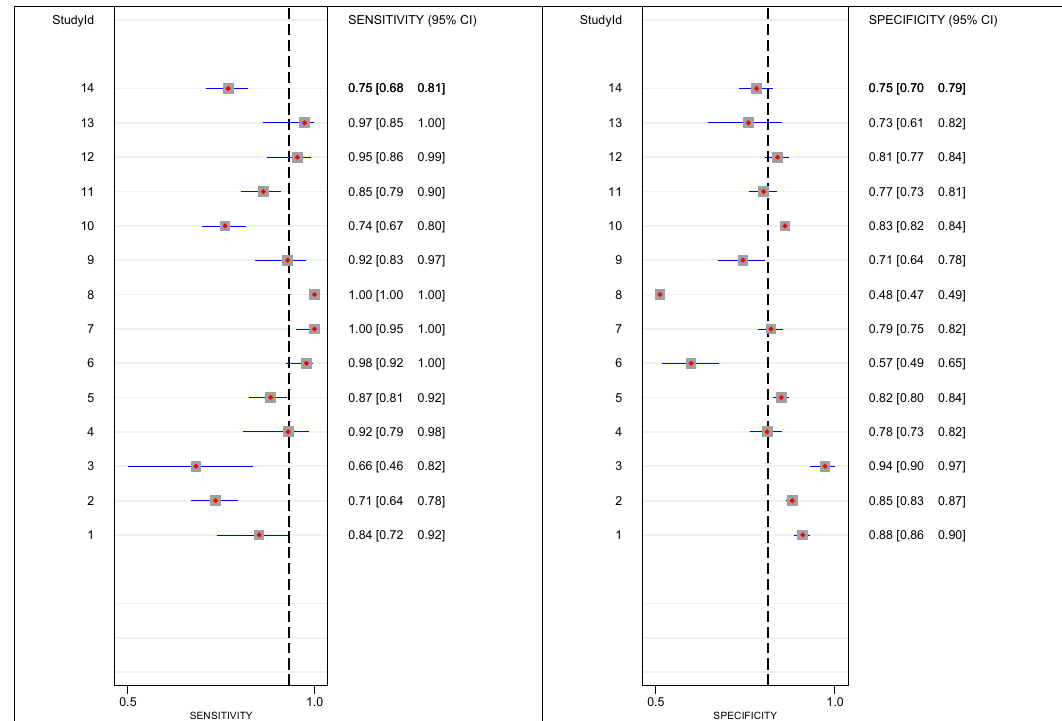
Figure 1. Graphical depiction of residual-based ( a ) goodness-of-fit, ( b ) bivariate normality, ( c ) influence and ( d ) outlier detection analyses.